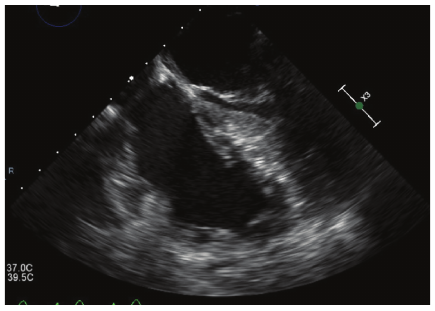
Figure 4: Post-EKOS TEE image (apical four-chamber view) showing resolution of previously noted serpiginous